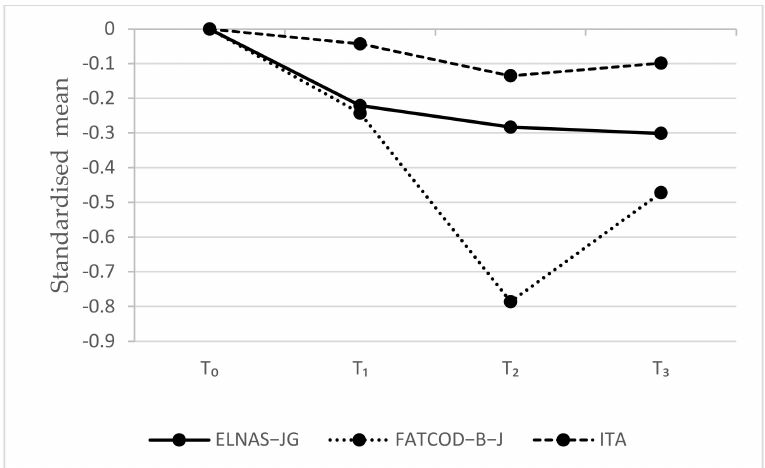
Figure A2. Changes in the standardized mean scores on the ELNAS-JG, FATCOD-B-J, and ITA for care workers. ( n = 33). Note: ELNAS-JG: End-of-Life Care Nursing Attitude Scale for Japanese Geriatric Nurses; FATCOD-B-J: Japanese version of the Frommelt Attitudes Toward Care of the Dying Scale; ITA (Abbreviated): Assessment Scale of Health Care Professionals’ Recognition of a Successful Interdisciplinary Team Approach in Health Care Facilities for the Elderly. Scores at the three timepoints (T 1 , T 2 , T 3 ) were standardized using the mean and standard deviation at baseline (T 0 ). Z = (x − µ 0 )/ σ 0 ; µ 0 and σ 0 indicate the mean and standard deviation, respectively, at T 0